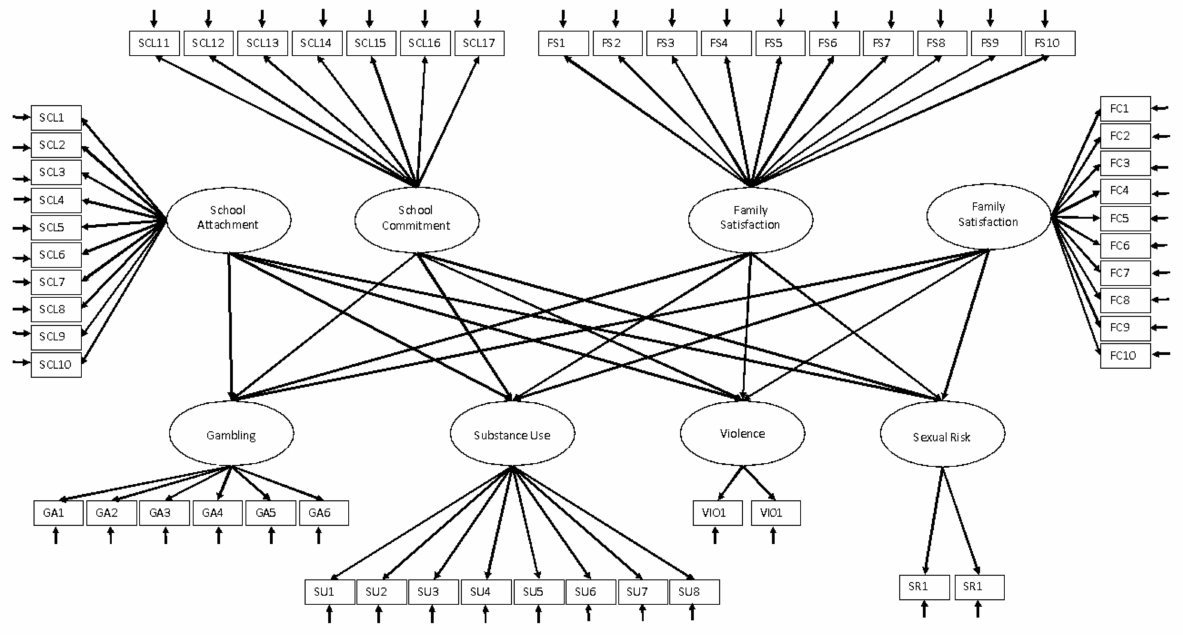
Figure 1. Structural equation model of the association between family and school protective factors with gambling, substance use, violence, and sexual risk